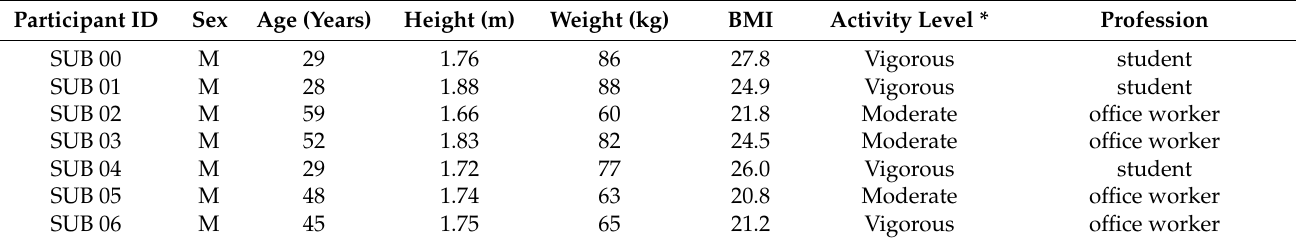
Table 1. Personal anthropometric